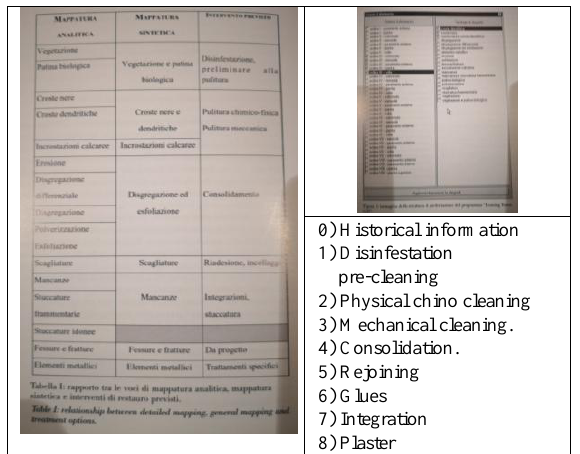
Figure 5. A sample of information system for maintenance